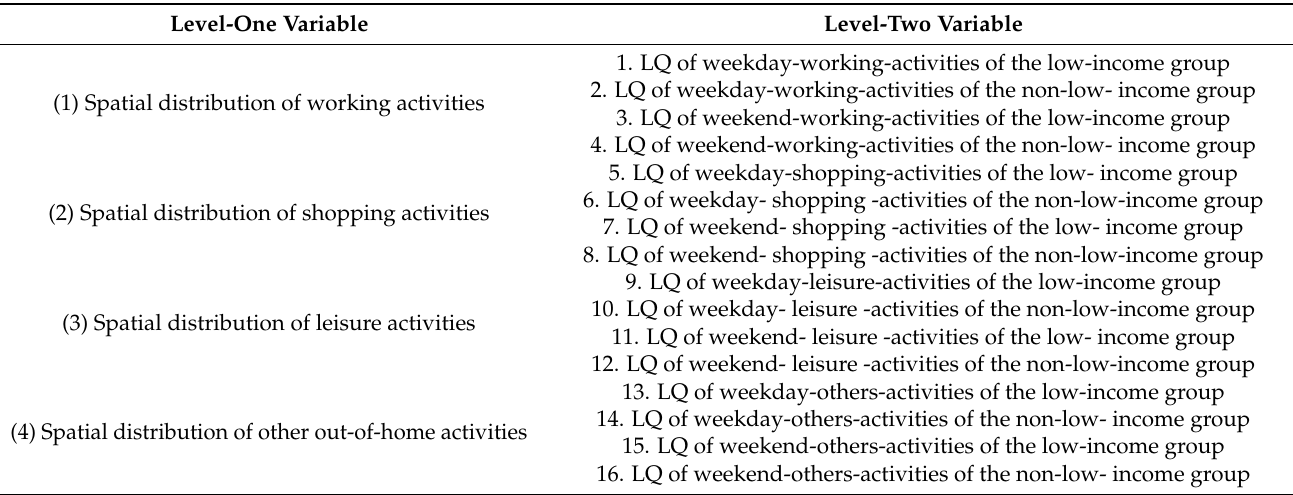
Table 1. Spatial distribution of daily activities and measurement indicators.